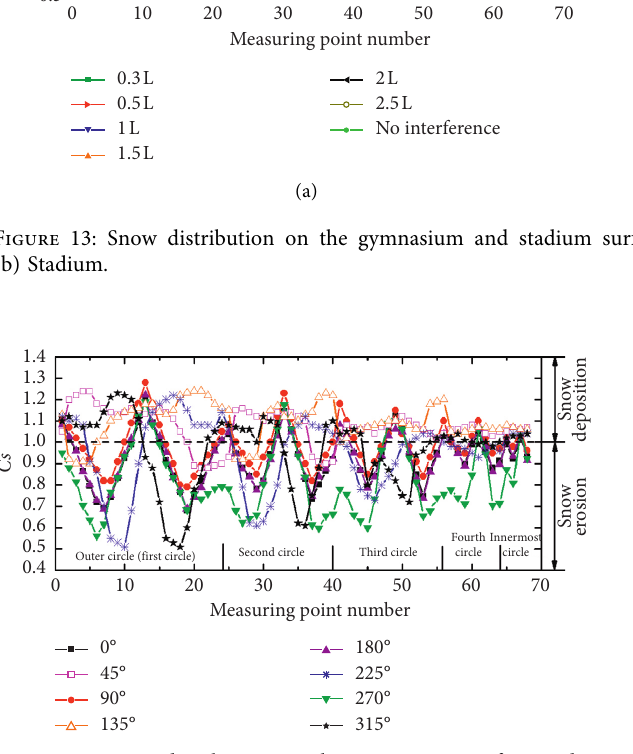
Figure 14: Snow distribution on the gymnasium surface under different wind direction